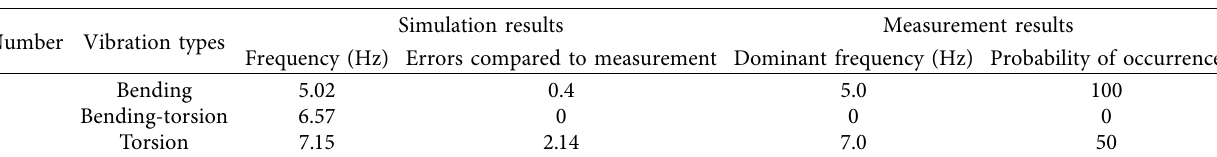
Table 3: The probability of occurrence of frequencies on Ben Noc bridge (obtained from